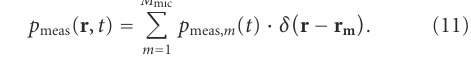
Algorithm 1: Digression on the measurement